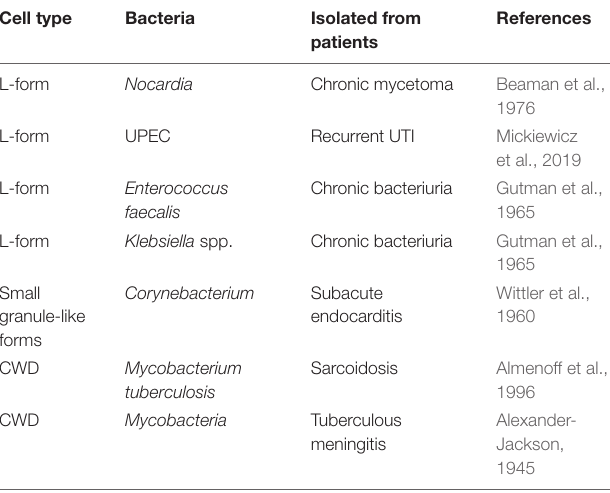
TABLE 1 | Cell wall-deficient bacteria associated with chronic